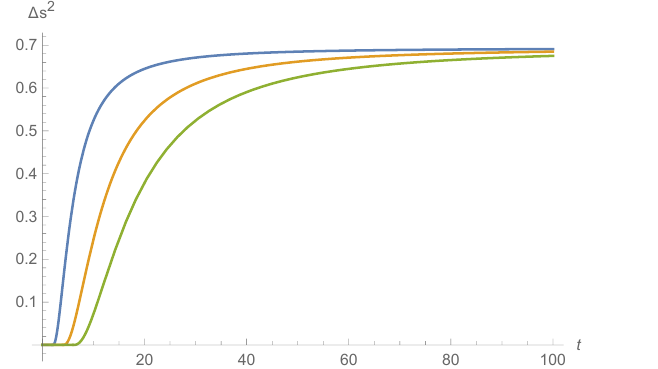
Figure 8. ∆ S (2) as a function for same components F ry of the field strength. Blue line: α = 2 , A α 0 = 400 ; orange line α = 4 , α 0 = 400 ; green line α = 5 , α 0 = 500 .